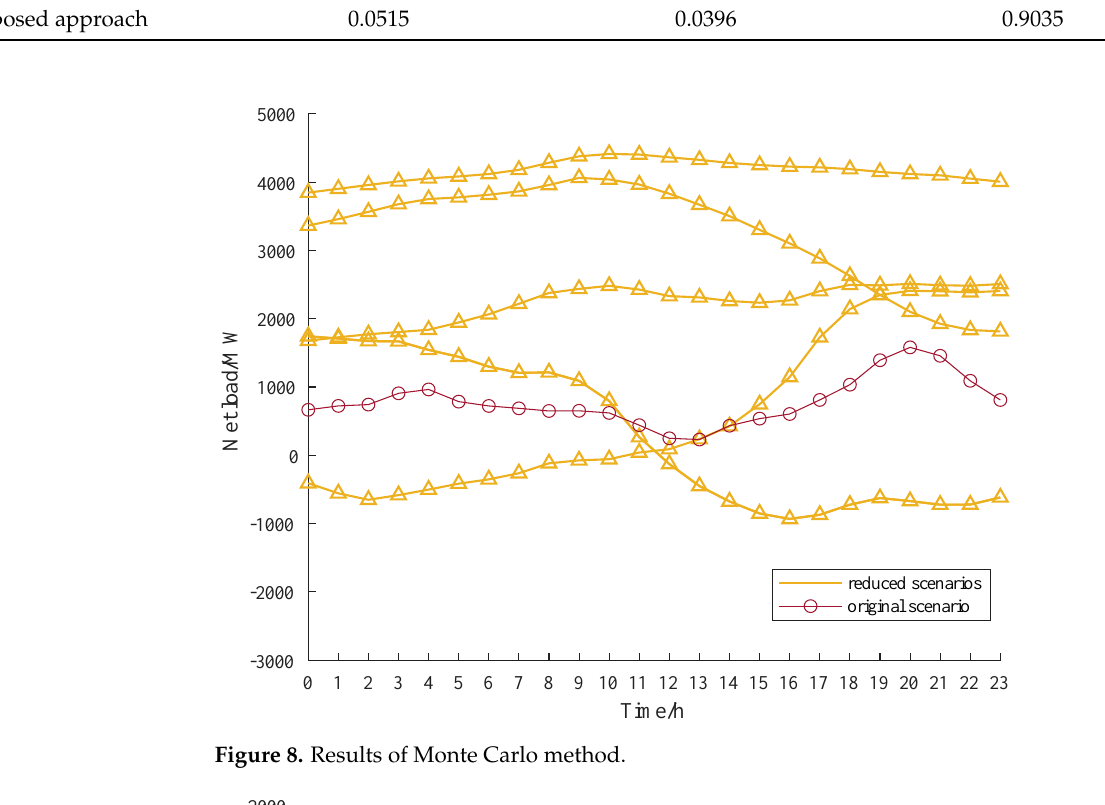
Figure 8. Results of Monte Carlo method.